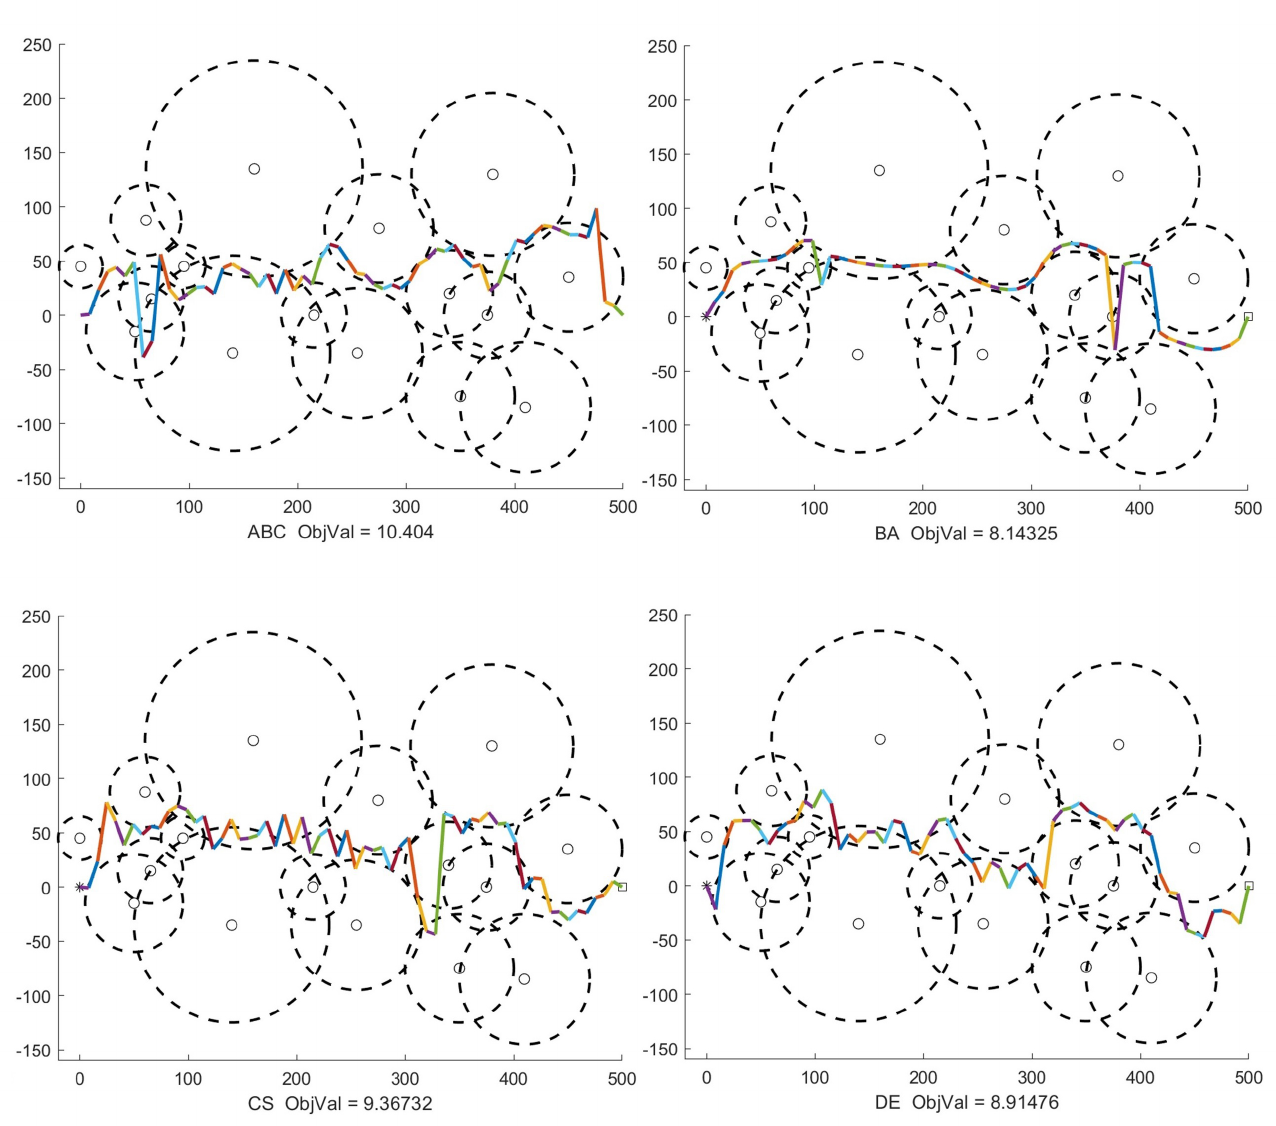
Figure 9. The comparison performance of different swarm intelligence algorithms including ABC, BA, CS and DE for Case 8 with D = 60, N =